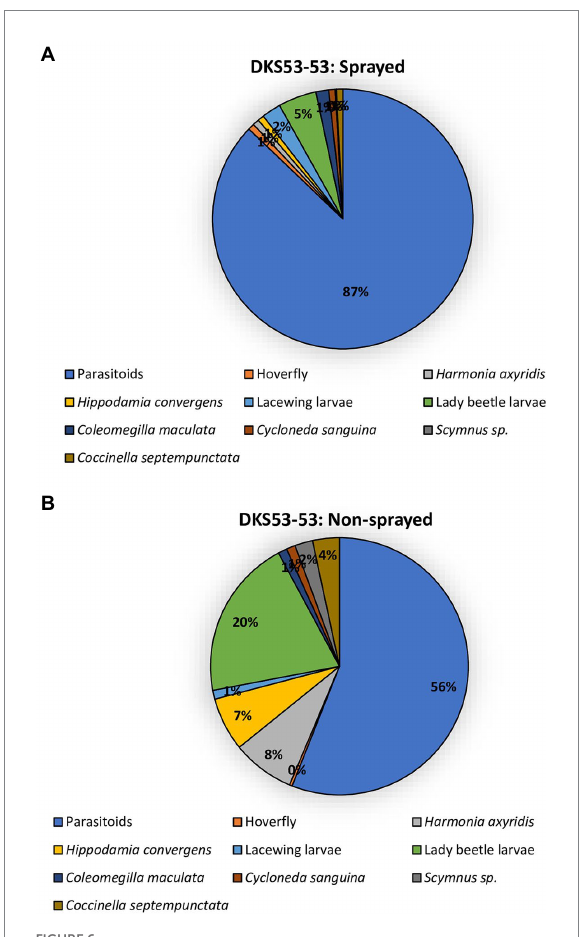
FIGURE 6 Percentage of natural enemies observed on susceptible sorghum cultivar (DKS53-53) that was flupyradifurone sprayed (A) or non- sprayed (B) using the pooled data from all